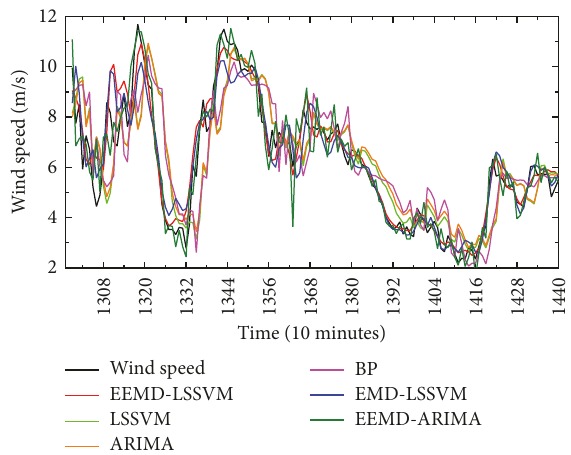
Figure 8: Three-step-ahead forecasting results (Case